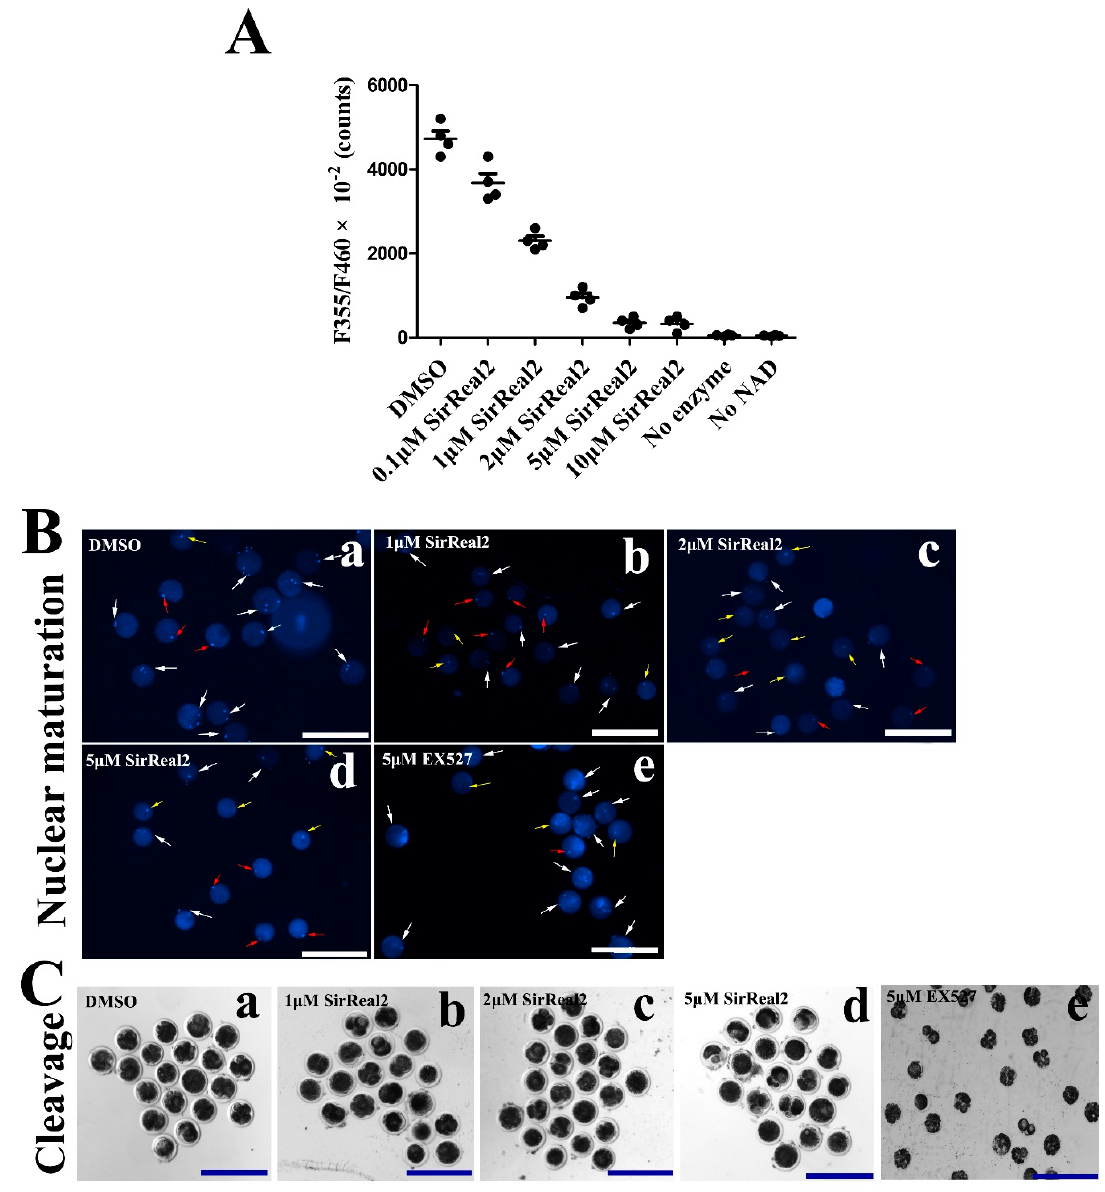
Figure 2. SIRT2 inhibition caused meiotic arrest in vitro. ( A ) Activity analyses of SirReal2-mediated SIRT2 inhibition. The activities of SIRT2 were shown as 355 nm/460 nm × 10 − 2 at concentrations of 0.1, 1, 2, 5, and 10 µ M SirReal2. ( B ) Representative images of the effects of SIRT1 or SIRT2 on the nuclear maturation of oocytes. Bovine oocytes were cultured in IVM medium supplemented with or without various concentrations of SirReal2 (b–d), DMSO (a), 5 µ M EX527 (e), respectively. Then, the nuclear maturation status was examined with DAPI. GV, MI, and MII oocytes are indicated by yellow, red, and white arrows, respectively. Scale bars: 300 µ m. ( C ) Representative images of cleavage embryos in the control (a), 1, 2, 5 µ M SirReal2-exposed (b–d), and 5 µ M EX527-exposed groups (e), respectively. Scale bars: 300 µ m.